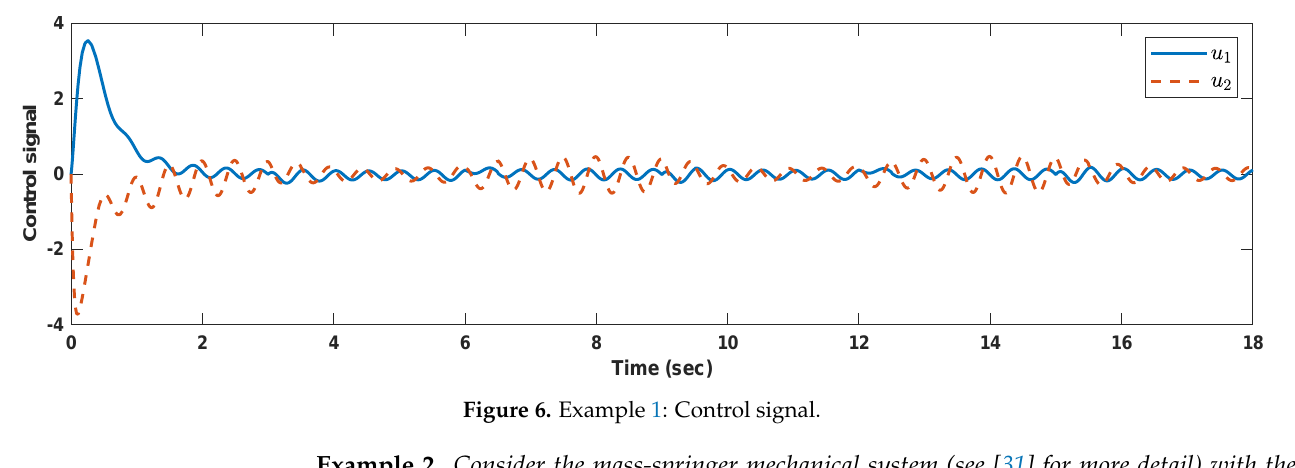
Figure 6. Example 1: Control